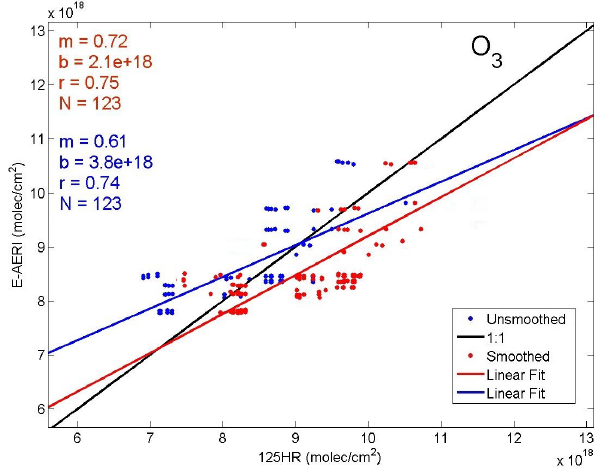
Fig. 8. Same as Fig. 5, but for 2011 O 3 total column comparisons for E-AERI vs. 125HR using a ± 3h coincidence